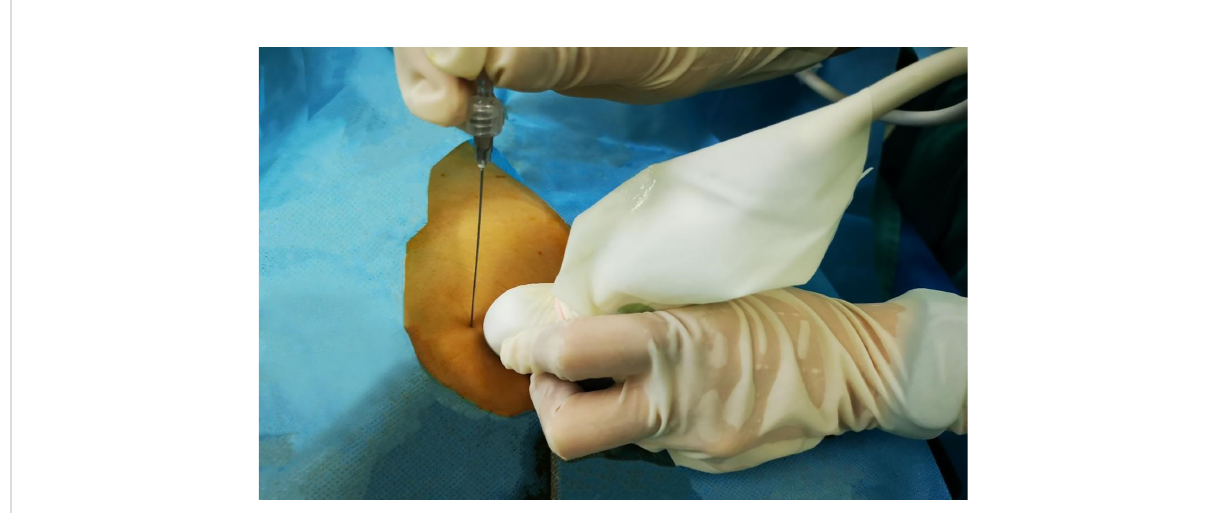
FIGURE 2 Ultrasound-guided paravertebral puncturing.